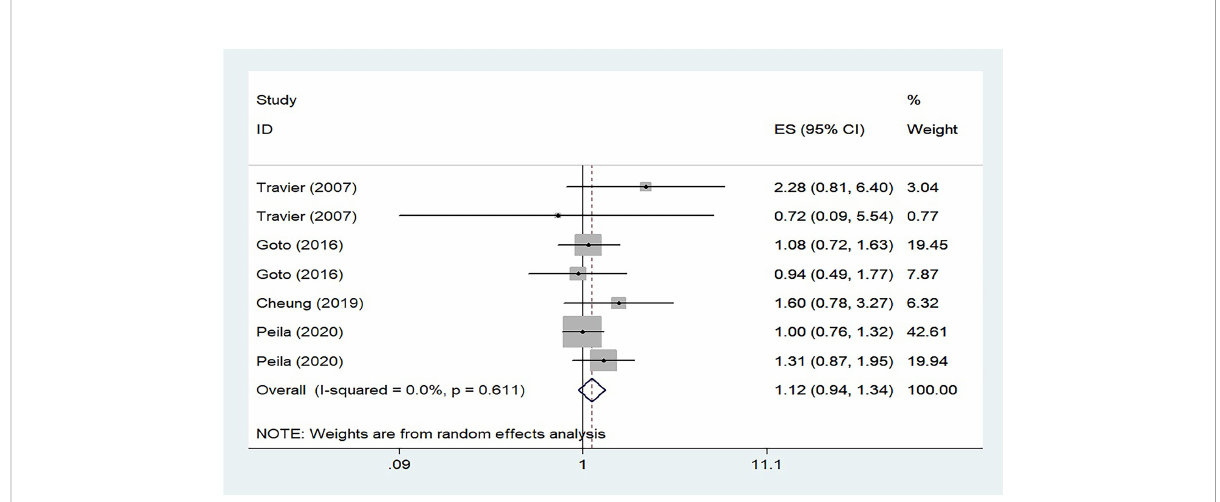
FIGURE 1 Forest plot of risk estimates for associations between serum HbA1c levels and risk of gastric cancer after eliminating Ikeda ’ s